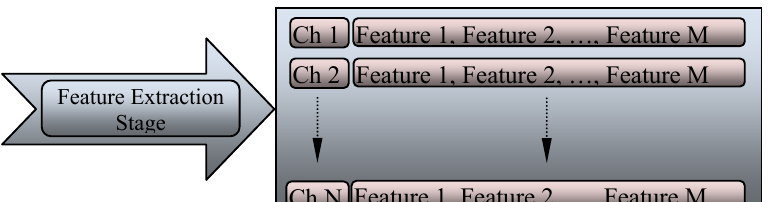
Figure 10. Multi-channel feature extraction stage.